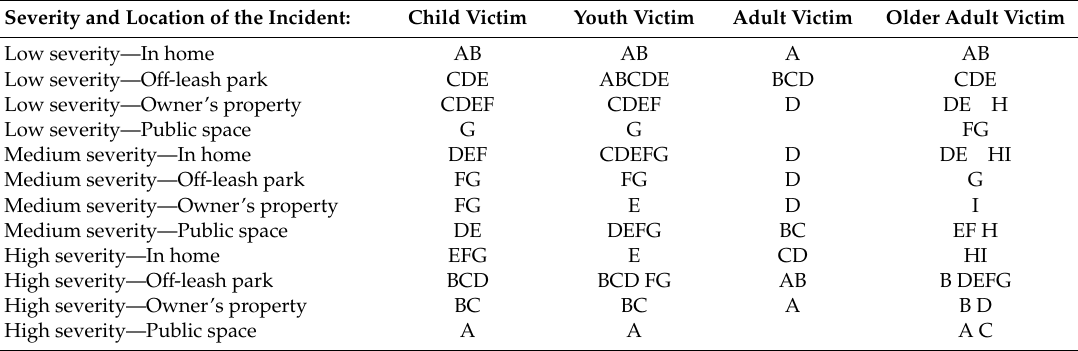
Figure 7. Predictive margins for the different severity incidents depending on the incident location and the victim age and controlling for other variables in the model. Table 4. Pairwise comparisons for each victim age group at each incident setting.